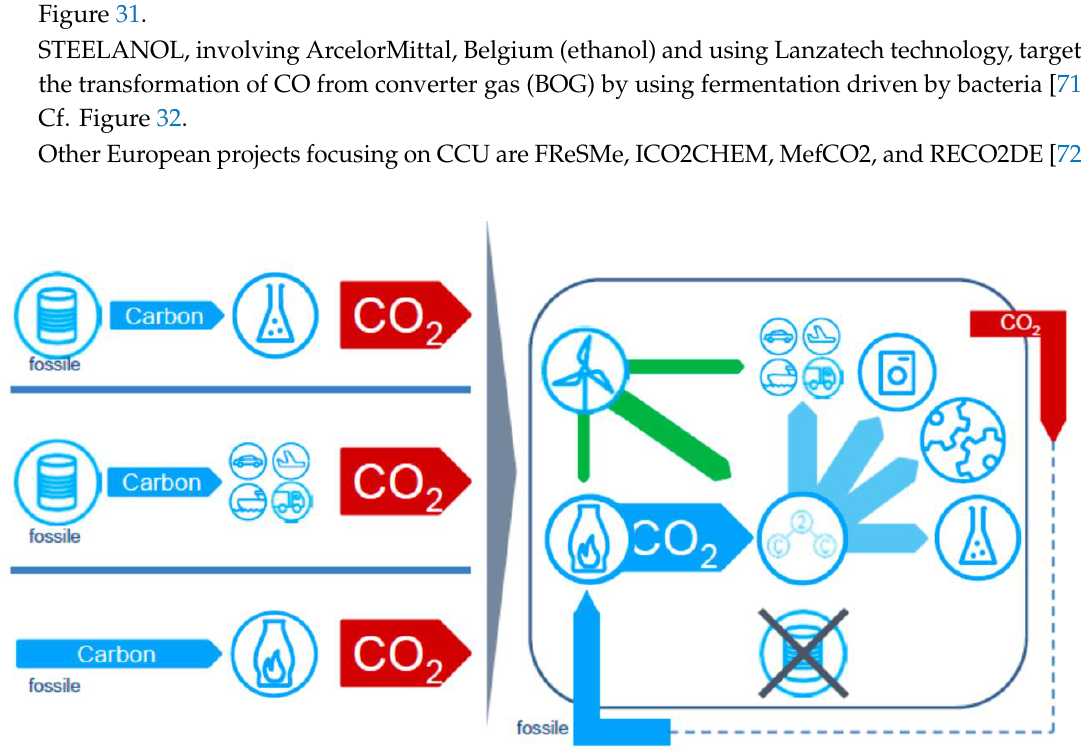
Figure 32. The STEELANOL project (source: ArcelorMittal). 5.9. Institutional Support to Low-Carbon Steelmaking Technologies Various institutions and organizations have been supporting the development of new low-car- bon steelmaking technologies. The rationale is, on the one hand, that only breakthrough solutions could deliver the very low emissions that climate change requires, and, on the other hand, that this would call for a tremendous effort in terms of time, continuity of purpose, and financial support. While the initial work on the topic goes back to the late 1980s and the early 1990s [73], the steel sector started to organize in the early 2000s and lobbied for financial support in the EU and in various countries from national funding agencies from that time on. This led to the ULCOS program , sup- ported by the European Commission under the RFCS and Framework programs, and to the CO 2 Breakthrough Program (CBP) of Worldsteel, where participants from all over the world would seek support from their own countries. For a period of about 10 years, research on low-carbon steelmaking was conducted under a single banner, with programs in the 5 –50 M€ range or slightly more. ULCOS was about to launch a second stage, ULCOS II, with a budget size an order of magnitude larger than the previous generation of projects. Financing had been arranged through the NER 300 program until the ULCOS-BF project collapsed due to the shutdown of the Florange Blast Furnace, decided as a consequence of the 2008 economic crisis.